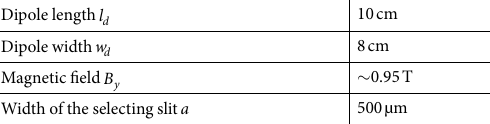
Table 1. Optimized combination of the selector parameters in order to obtain a final energy spread < 20% for the energy range 2–20 MeV. The considered initial divergence is 3 mrad